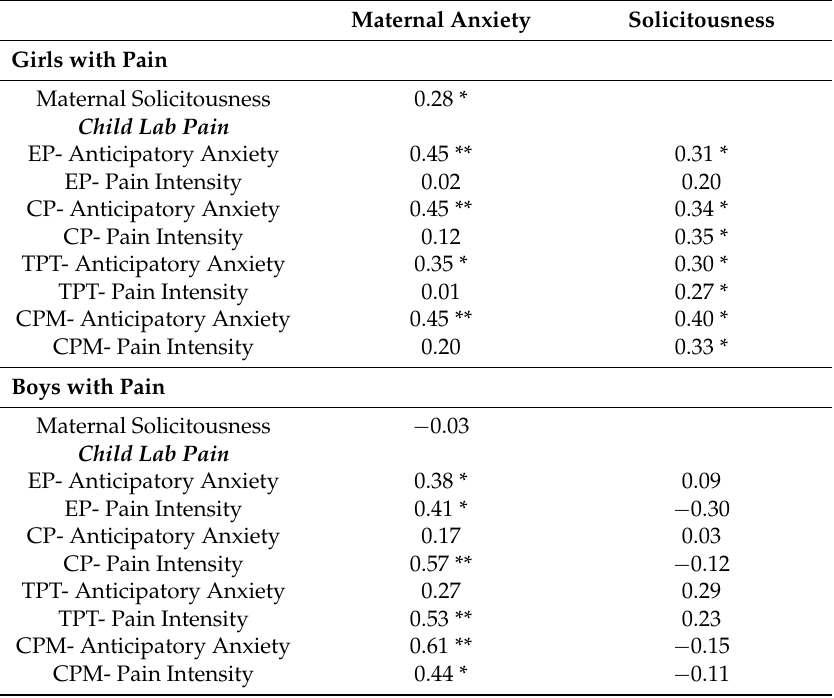
Table 3. Correlations among maternal and child lab